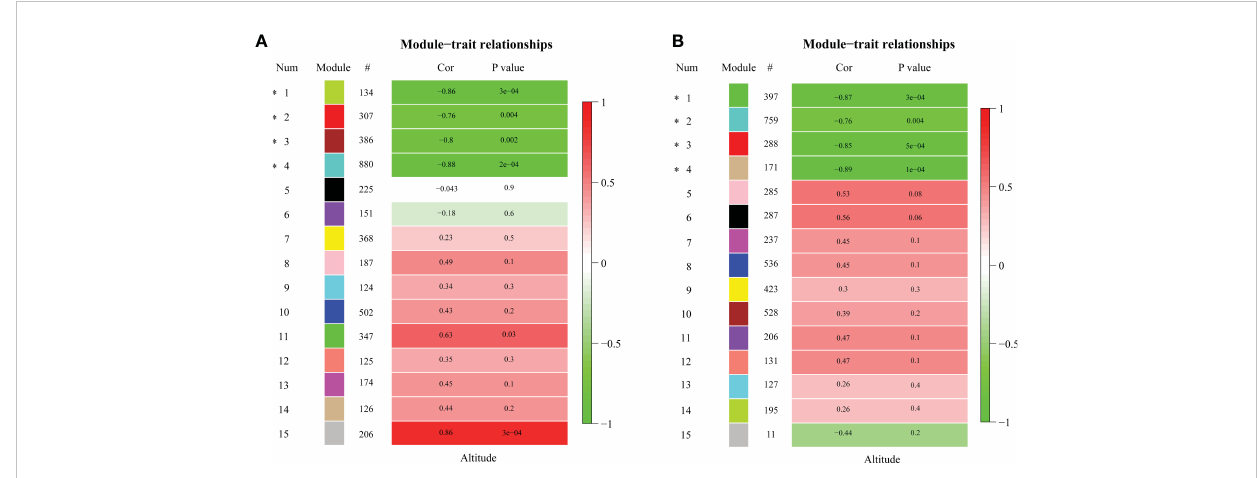
FIGURE 4 Pearson ’ s correlation coef fi cient (Cor) and corresponding signi fi cance level ( P value) between the expression of genes in each module and the sample altitude from (A) late fl ower buds and (B) early leaf buds. “ # ” indicates the number of genes in each module. Asterisk indicates altitude- related module. The color bar to the right of each fi gure indicates the strength of correlation coef fi